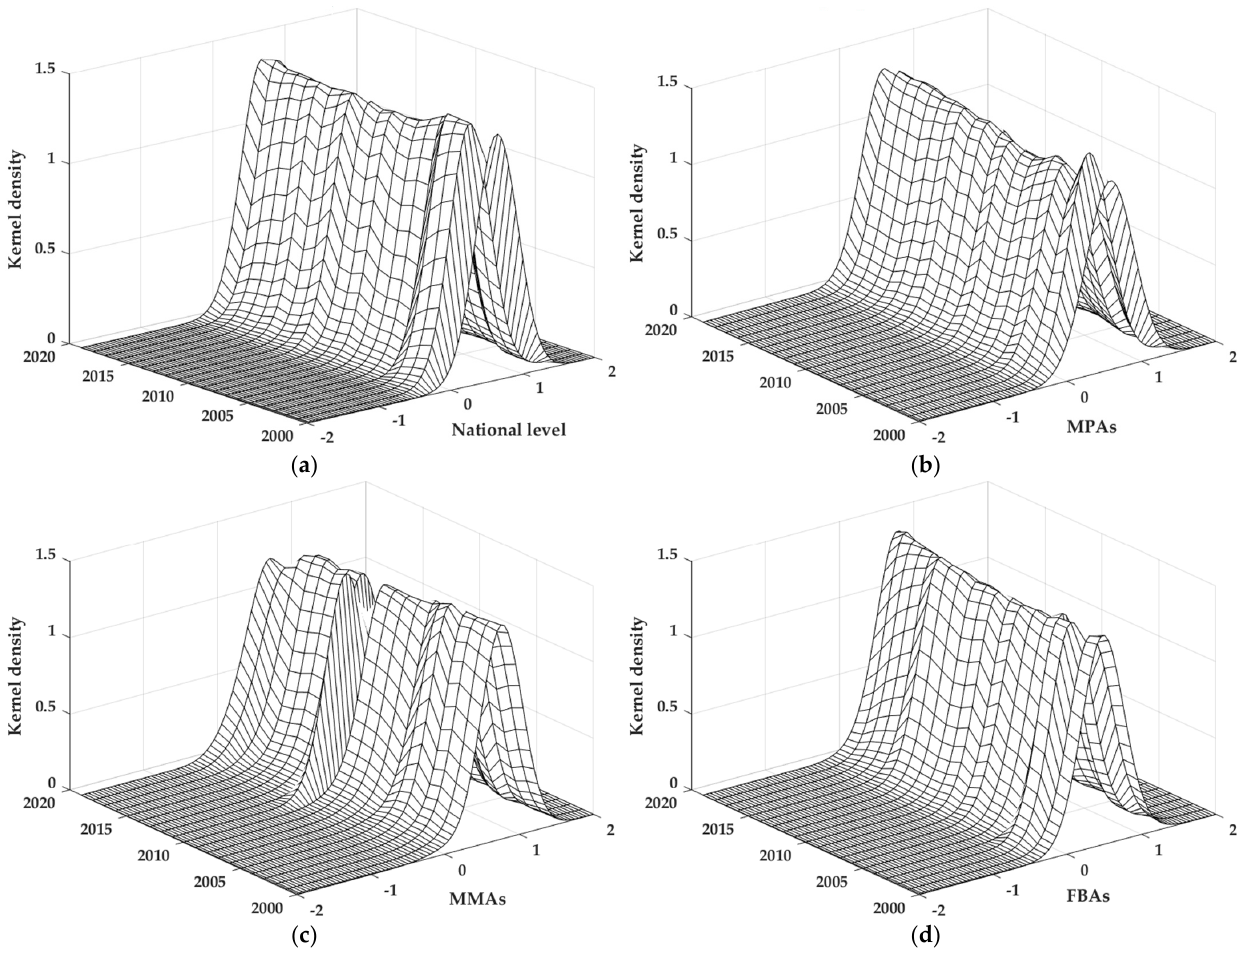
Figure 5. Kernel density estimation of the national level and different food functional areas. Note: This figure is drawn by the authors themselves using MATLAB based on the calculation results. ( a ) National level; ( b ) FPAs; ( c ) FMAs; ( d ) FBAs.